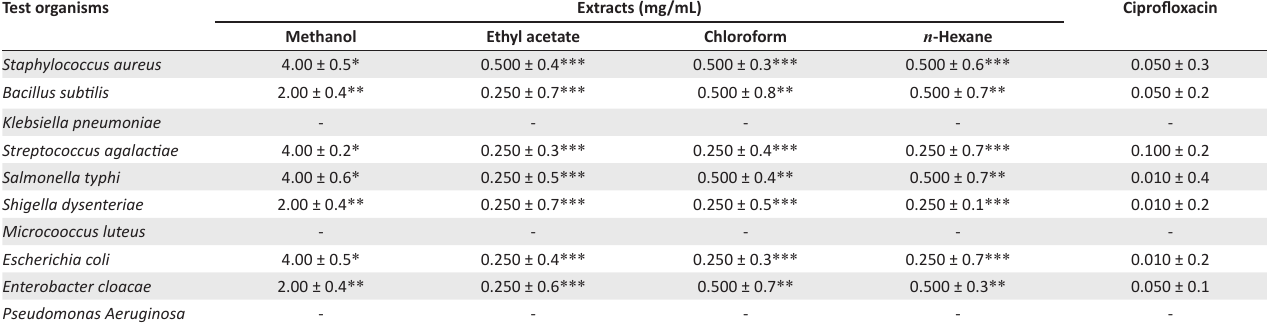
TABLE 4: Minimum bactericidal concentration in mg/mL of root extracts from P. oleracea . Test